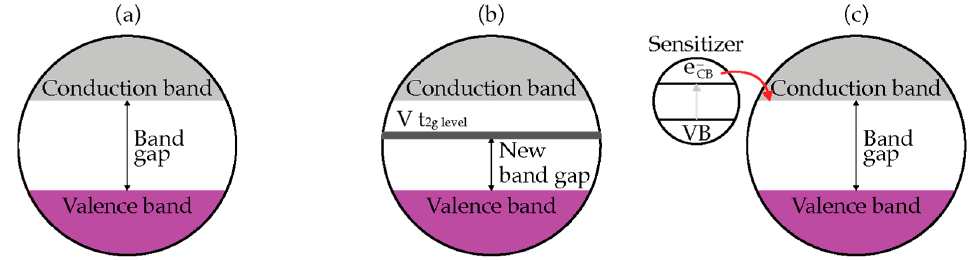
Figure 6. Improving optical response of ( a ) TiO 2 , ( b ) V-doped TiO 2 , ( c ) sensitization by narrow bad gap semiconductor